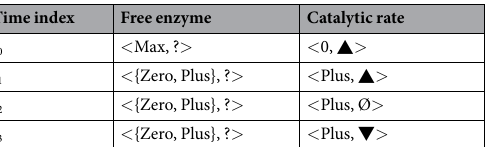
Table 2. Declining hydrolysis rate after an initial burst of hydrolytic activity (TB1).